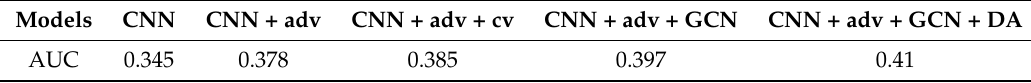
Table 5. AUCs of different